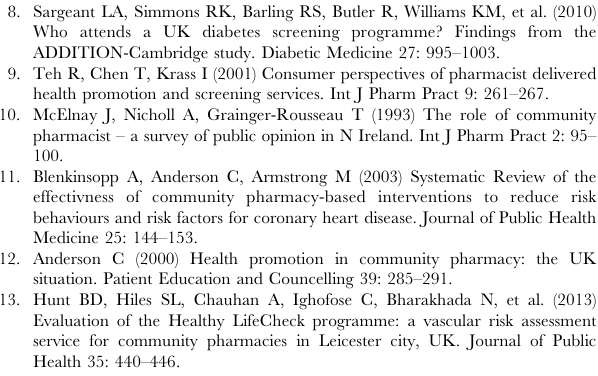
Figure 4. Percentage of individuals exceeding cut offs by risk factor. i. Diabetes. ii. Hypercholesterolemia. iii. Hypertension.